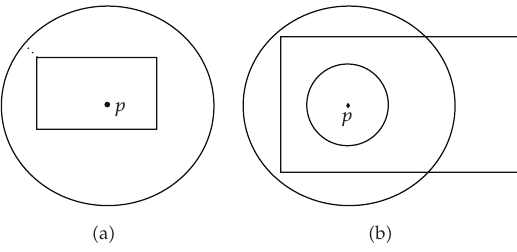
Figure 1: (cid:3) a (cid:4) The error is positive. (cid:3) b (cid:4) The error is zero.